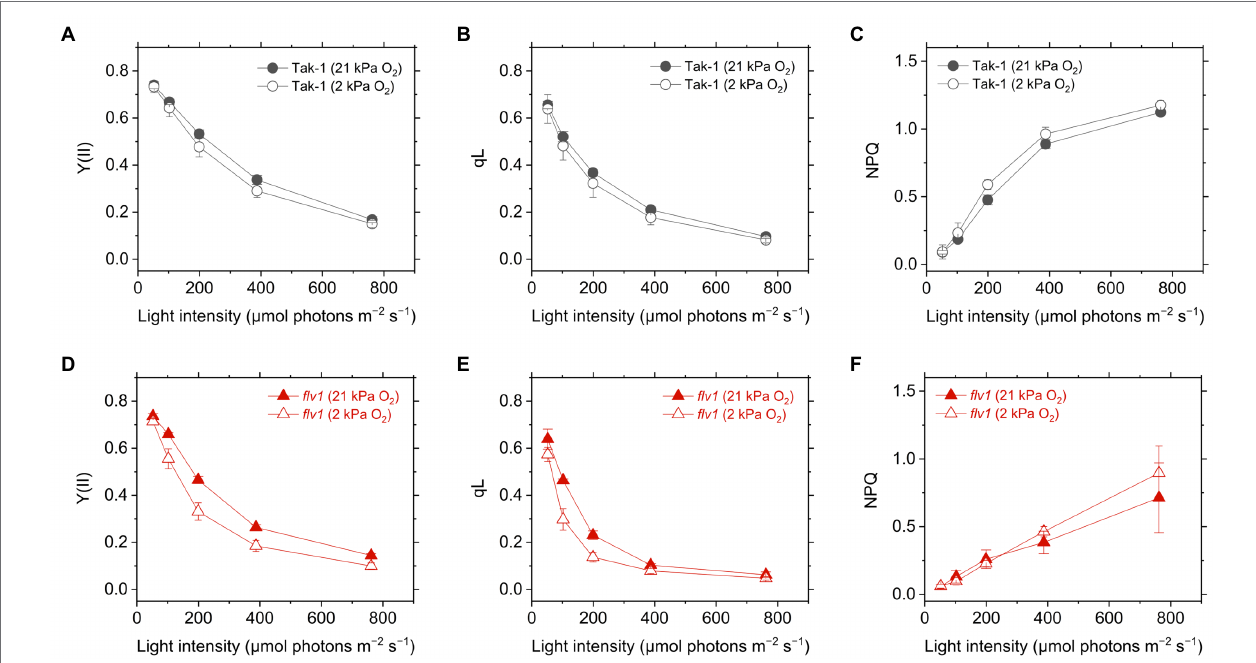
FIGURE 3 | Effective quantum yield of PSII, Y(II) (A,D) , inferred oxidation level of plastoquinone pool (qL) (B,E) , and non-photochemical quenching (NPQ) of PSII (NPQ; C,F ) in the liverwort M. polymorpha (Tak-1; A–C ) and the mutant flv1 (D–F) . Experiments were performed under 21 (closed symbols) and 2 kPa O 2 (open symbols). Data are shown as the mean with the standard deviation ( n = 3, biological